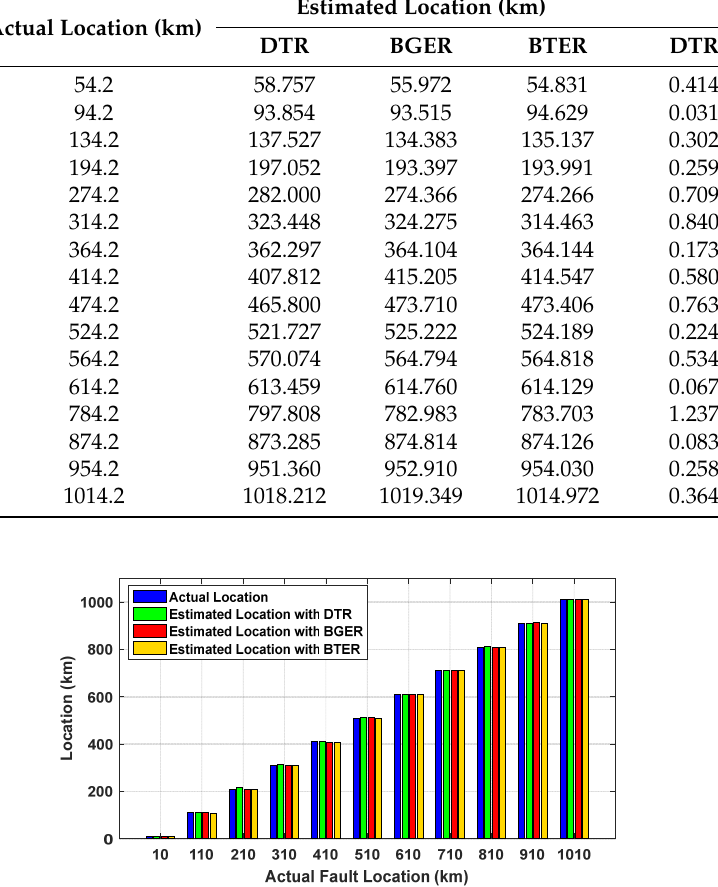
Figure 10. Estimated fault location during P1G fault in 100 Ω